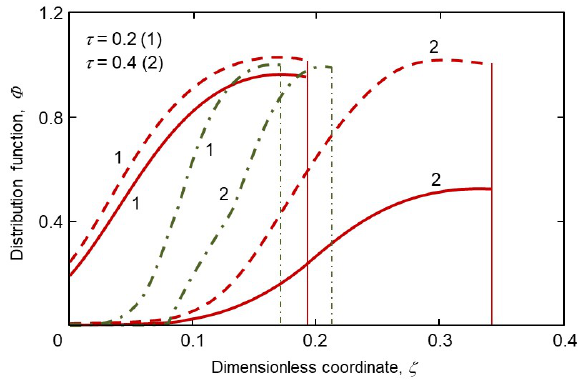
Figure 2. Particle-radius distribution function Φ ( ζ , τ ) versus dimensionless radius ζ . Numbers at the curves indicate various times τ . The red dashed and solid curves are illustrated for H = 0 and H = 3, respectively, ( Q = 0.05). The green dash-dotted curves are plotted for Q = 0 and H = 0. The maximum radii ζ m ( τ ) of crystals are shown by the perpendiculars to the abscissa